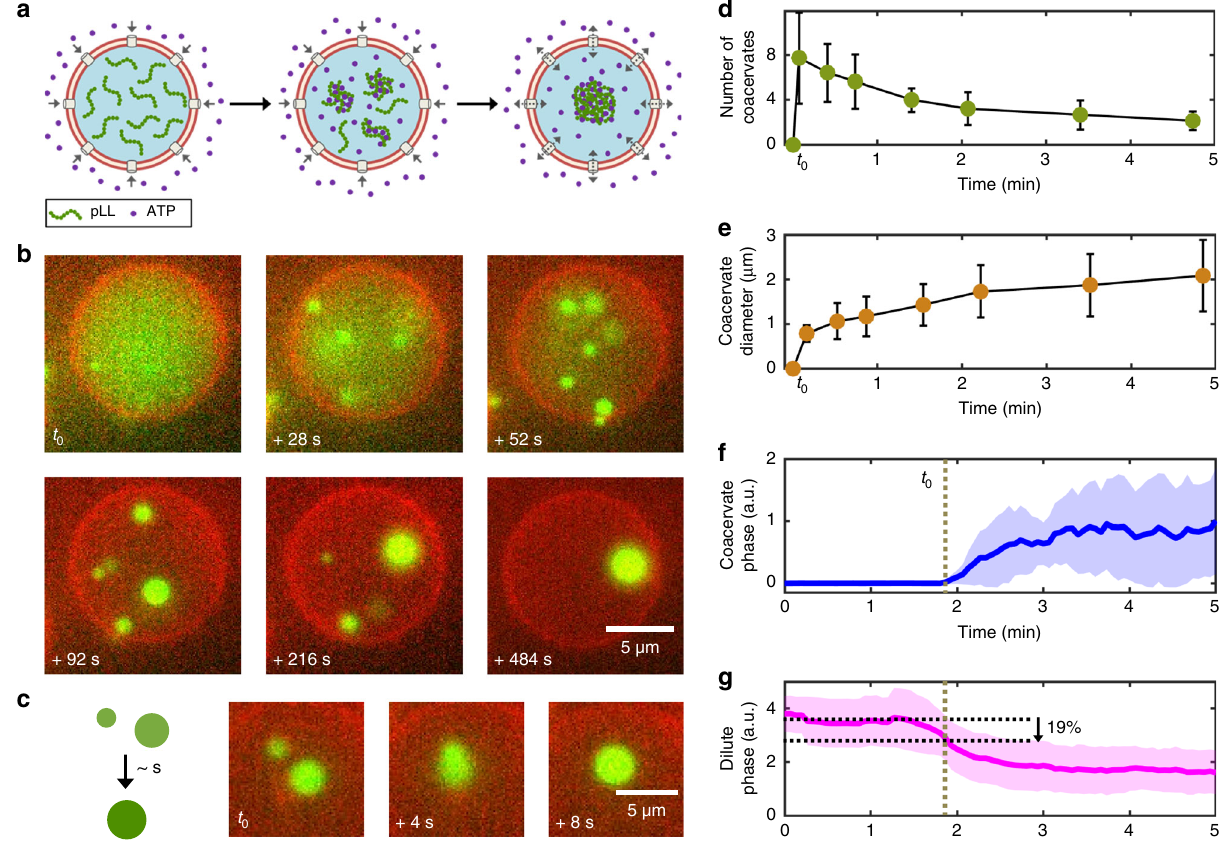
Fig. 2 pLL/ATP coacervate formation within liposomes through in fl ux of ATP. a A schematic showing the formation of a pLL/ATP coacervate within a liposome. ATP from the environment diffuses inside the liposome through α -hemolysin pores. It interacts with pLL molecules present inside the liposome, initiating coacervation throughout the liposome. Over time, individual coacervates coalesce to form a single coacervate. b Time-lapse fl uorescence images (red: lipid bilayer; green: FITC-pLL) showing the coacervation process inside a liposome. Note the simultaneous formation of multiple coacervates that further coalesce to form one single entity. Time zero ( t 0 ) corresponds to the fi rst visible sign of coacervation. c Schematic and a typical example showing coalescence of two coacervates, a characteristic feature of liquid droplets. d Average number of coacervates present inside a liposome as a function of time. After the initial burst of multiple coacervates (~8) throughout the liposome, the average number decreased to about 2 within the next 5 min. e Evolution of the average coacervate size with time. Initially formed small coacervates (~1 µ m) subsequently fuse with each other, to ultimately form a ~2 µ m coacervate that freely diffuses inside the liposome. f Coacervate-phase intensity versus time ( n = 12 liposomes, obtained from a single experiment). The rapid transition from a homogeneous solution to a condensed phase leads to sudden rise in the fl uorescence intensity, which plateaus over time. g A plot of the dilute-phase intensity over time ( n = 12), showing a complementary rapid decay. The horizontal dashed lines indicate the decrease in the fl uorescence intensity just before coacervation takes place, providing evidence for nucleation events. See Methods for details of the analyses involved for panels ( d – g ). Error bars in ( d , e ) indicate standard deviations. Dashed vertical lines in ( f , g ) indicate the onset of coacervation, the plots show the average values, with the shaded regions indicating standard deviations. Source data are provided as a Source Data fi